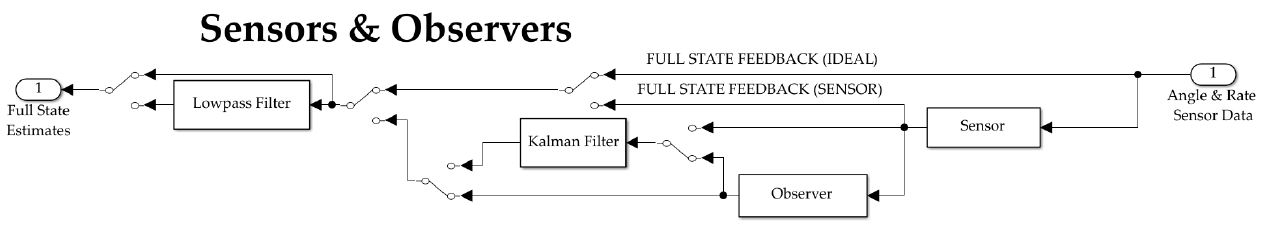
Figure A6. MatLab model with complete detailed display of the controllers and actuators Simulink subsystem.